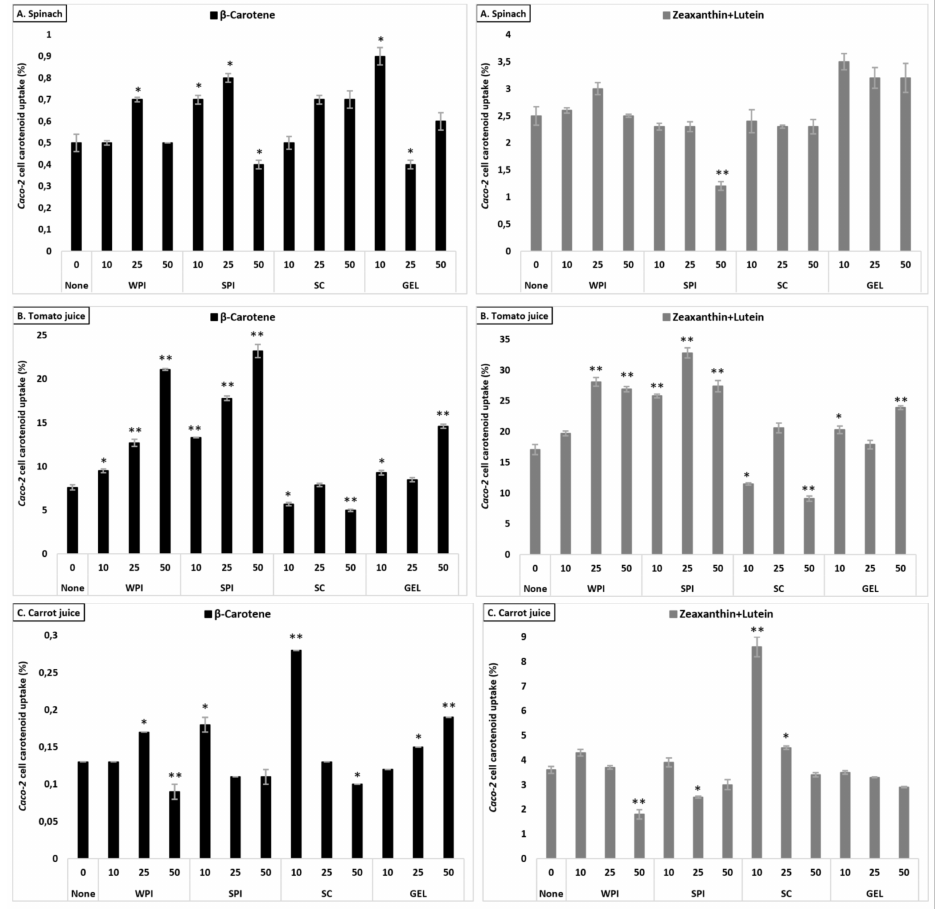
Figure 3. Average cellular uptake (%) of carotenoids from spinach ( A ), tomato juice ( B ), and carrot juice ( C ). The investigated matrices were studied following in vitro GI digestion. Each bar represents the cellular uptake of either β -carotene or lutein+zeaxanthin recovered in the cell fraction compared to the original, matrix content (considering all dilutions). Bars represent means ± SD of n = 3. Columns labelled with either * ( p < 0.05) or ** ( p < 0.001) were significantly different from the control condition (no added